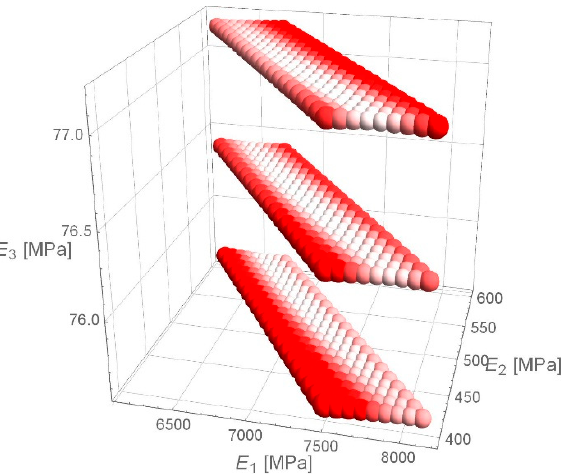
Figure 11. e RMS error for individual combinations of material parameters—cuboidal domain. For D1 variant, the dispersion of strain was significantly smaller than the dispersion of material stiffness moduli. The dispersion of stiffness moduli in D1 case resulted